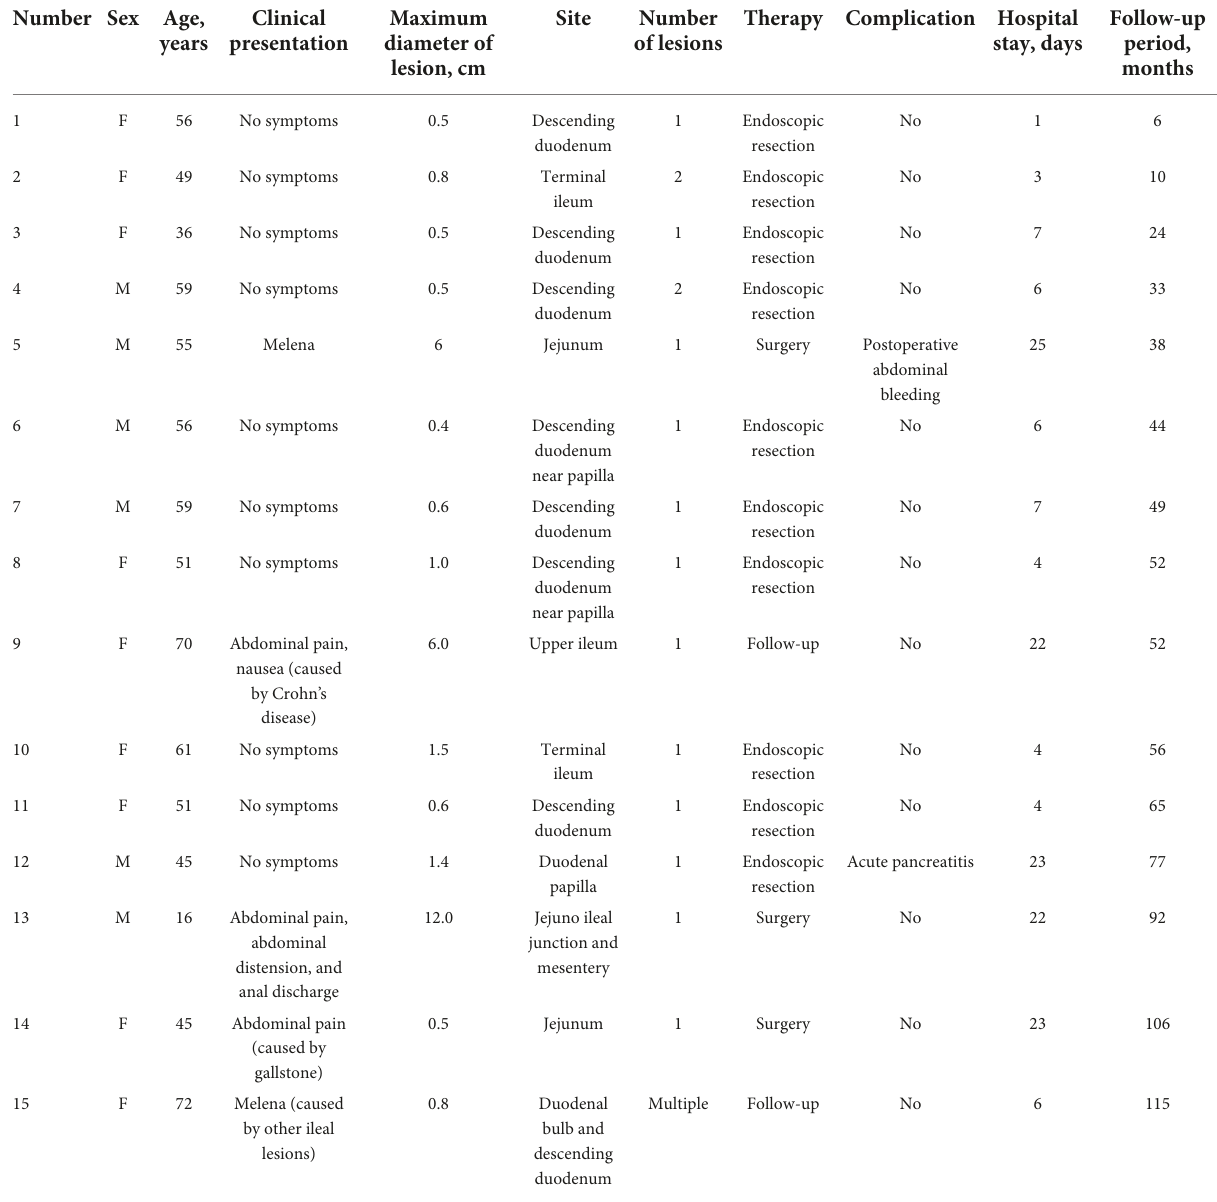
TABLE 1 Clinical characteristics of 15 small bowel lymphangioma cases. Number Sex Age,